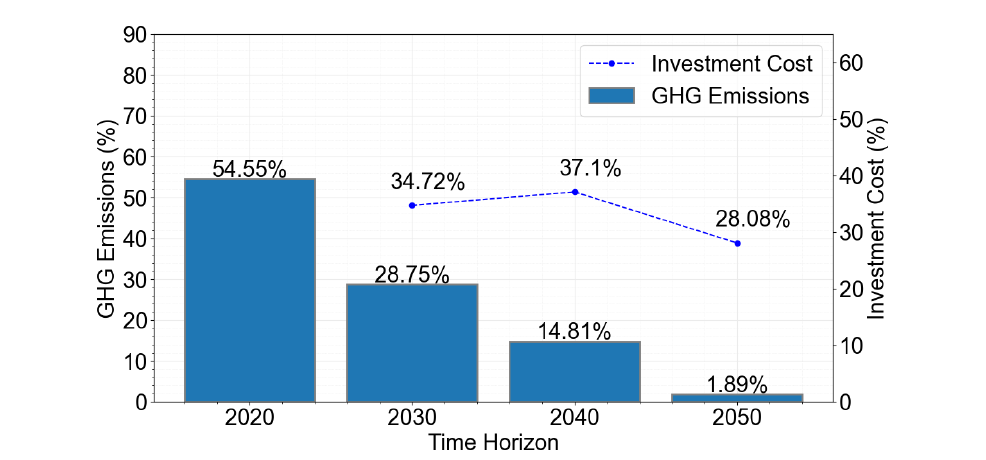
Figure 12. Alternative 3—Comparison between emissions and the investment cost for the Residential sector.